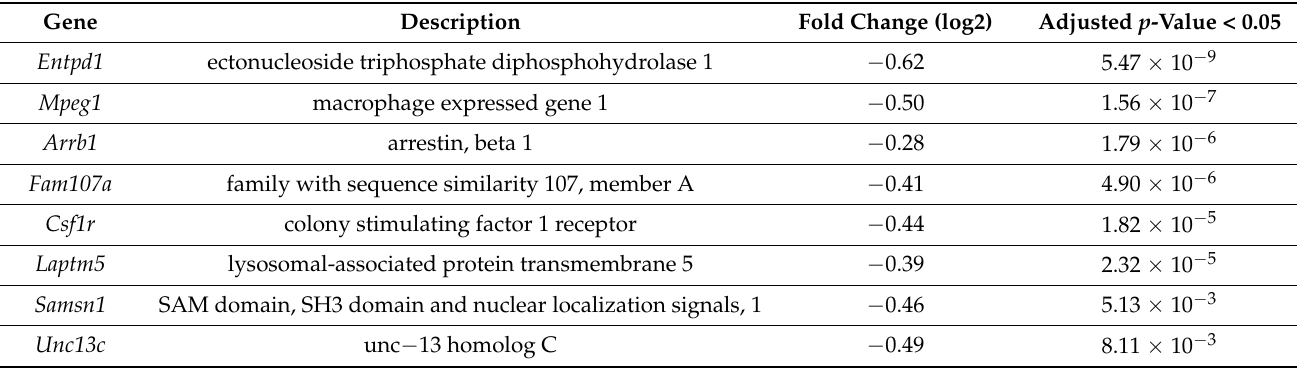
Table 2. Significantly differentially expressed genes related to AD.